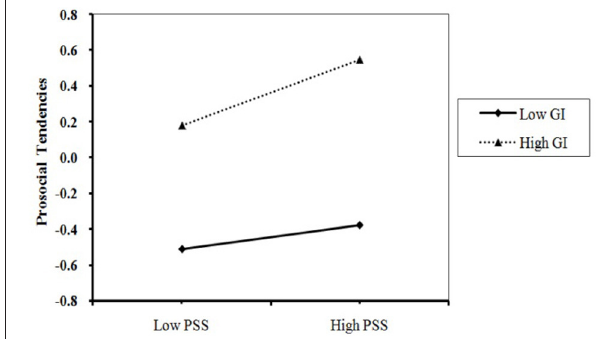
FIGURE 2 | Moderating effect of in-group identity on the prediction of prosocial tendencies.